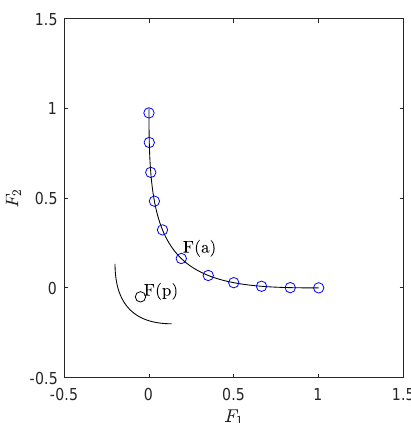
Figure 2. A hypothetical scenario that can happen for multi-modal problems: first, a front that is only locally optimal is detected by the search process and approximated by the archiver. If later, a candidate p is computed such that F ( p ) lies on a “better” front, the current values of ∆ and (cid:101) may not be adequate any more to suitably approximate this